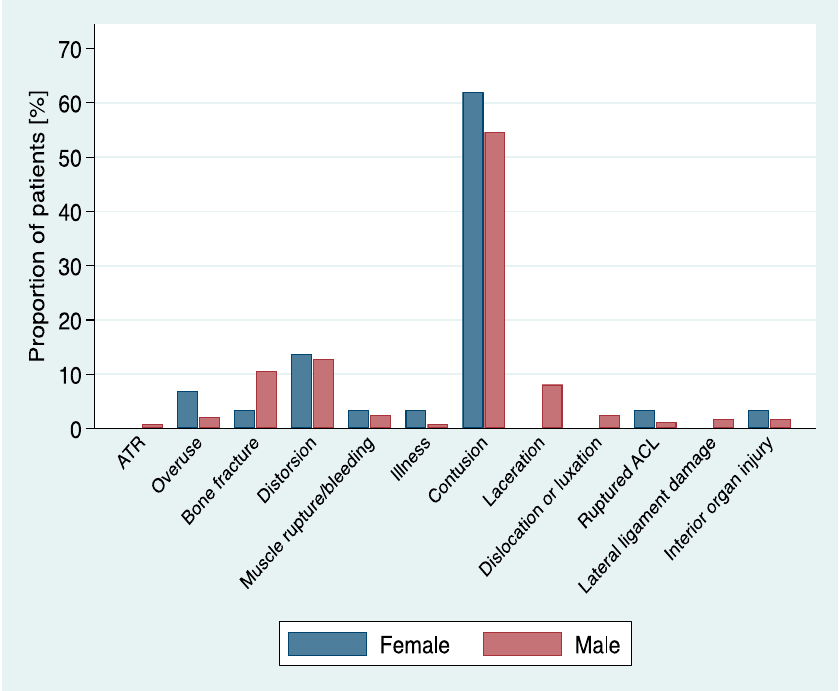
Figure 2. Distribution of type of